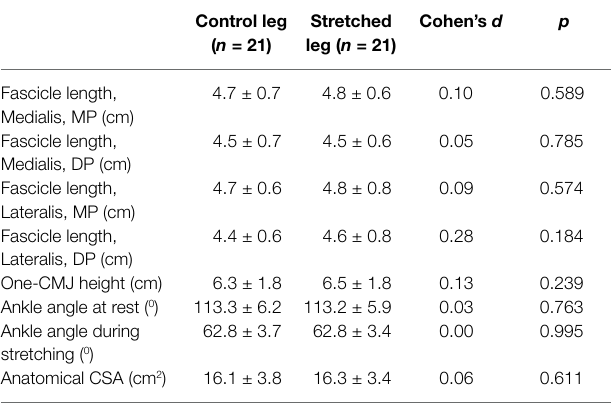
TABLE 2 | Baseline evaluation of the gastrocnemius heads fascicle length and muscle anatomical cross-sectional area (CSA), ankle angle and jump performance in 21 adolescent volleyball players used for the legs’